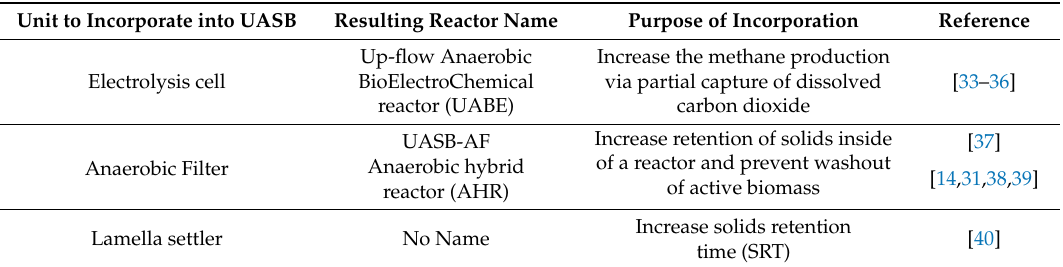
Table 1. Existing hybrid versions of UASB